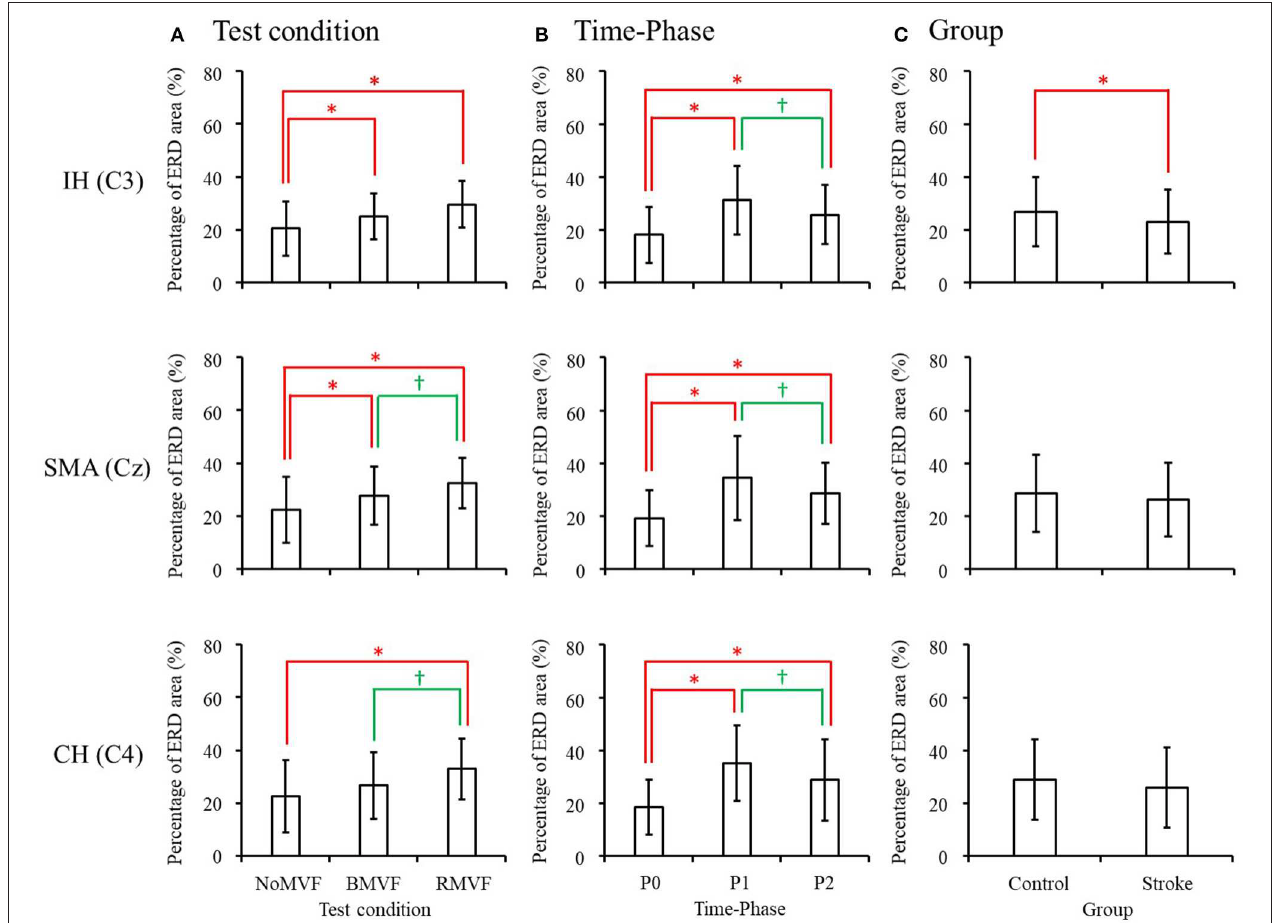
FIGURE 6 | Three-way repeated-measures analysis of variance in the beta band revealed that both test condition and time-phase have main effects in all three brain areas, while group also had a main effect in the IH brain area (C3). Comparison of the mean value of event-related desynchronization (ERD) areas for each main effect are shown for (A) test condition, (B) time-phase, and (C) group. * , † ERD areas (%) of this test condition, time-phase, or group are significantly higher than the previous one in each